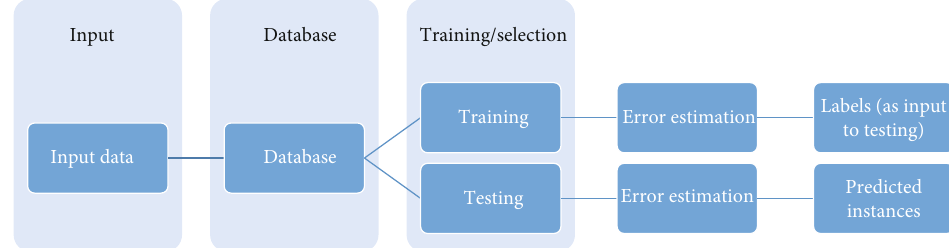
Figure 1: Machine learning approach for optimal placement via